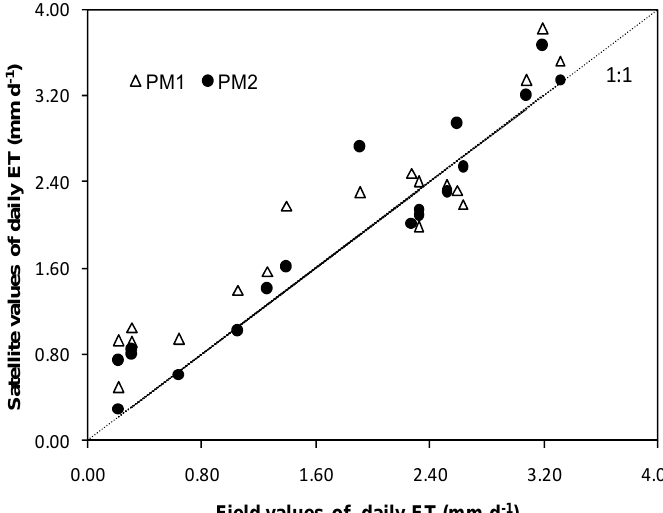
Figure 5. Relationships between satellite and field measurements of daily actual evapotranspiration. ( a ) using the modeled evapotranspiration resistances (PM1). ( b ) using the modeled ET/ET ratio 0